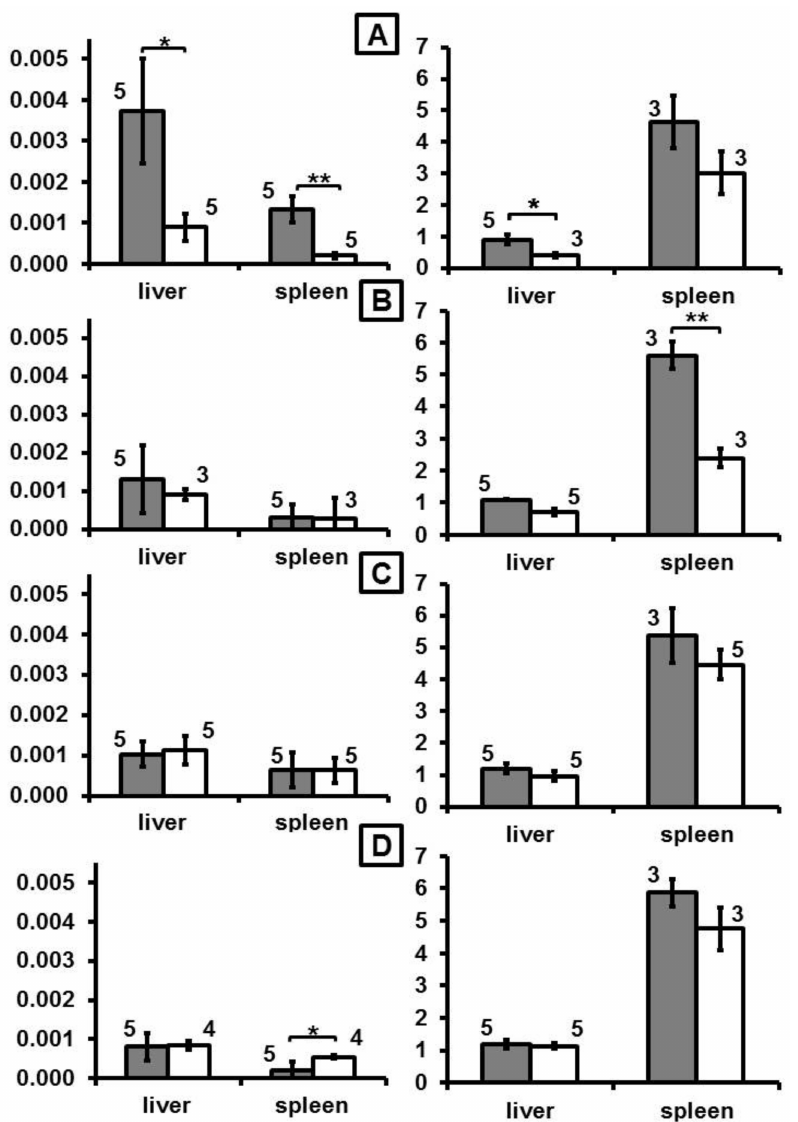
Figure 1. The time-dependent organ distribution fluorescence of the dye DY-730 attached to the iron oxide magnetic nanoparticles and the iron concentration in the organs. ( A – D ): 0, 2, 4, and 6 months after MNP injection in mice, respectively. Left panel: semiquantitative fluorescence intensity (em: 755 nm, arbitrary units per s, n = 5); right panel: iron content (mg iron per g tissue, n = 3). Nude mice were injected with dually-labelled MNP-D(DY-730)-PEG-5kDa(DY-555) (200 µ mol Fe / kg body weight). Gray and white bars: after MNP injection or native controls, respectively. At the defined time points, animals were killed and semiquantitative fluorescence intensities of each fluorochrome in excised organs were determined. ROI: 916 pixels n = 5, mean and standard deviation of the mean, * p < 0.05; ** p < 0.01, Tukey post-hoc Test. PEG: poly-ethylene